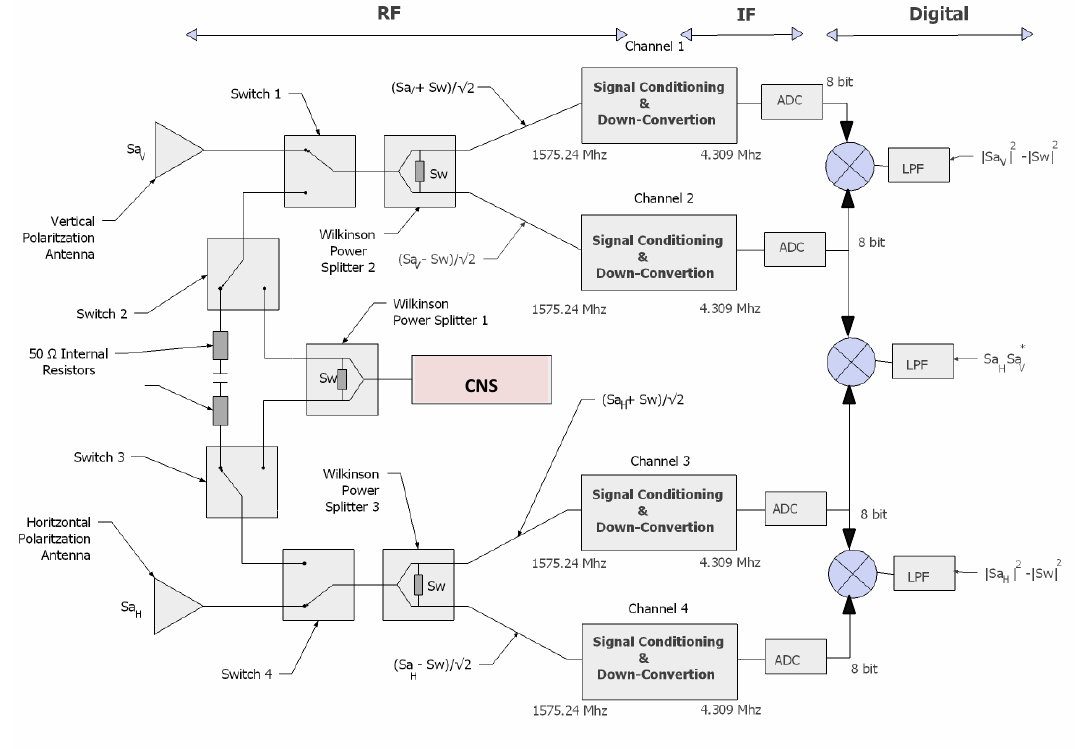
Figure 2. PAU-RAD concept explained through a one element sketch. The antenna signal at each polarization is split in two by a Wilkinson power divider. The correlation of the channels of the same polarization is proportional to the antenna temperature minus the Wilkinson’s resistor physical temperature, as in the case of a Dicke radiometer. The correlation of the two channels of different polarizations is a complex value proportional to the third Stokes parameter (real part) and the fourth Stokes parameter (imaginary